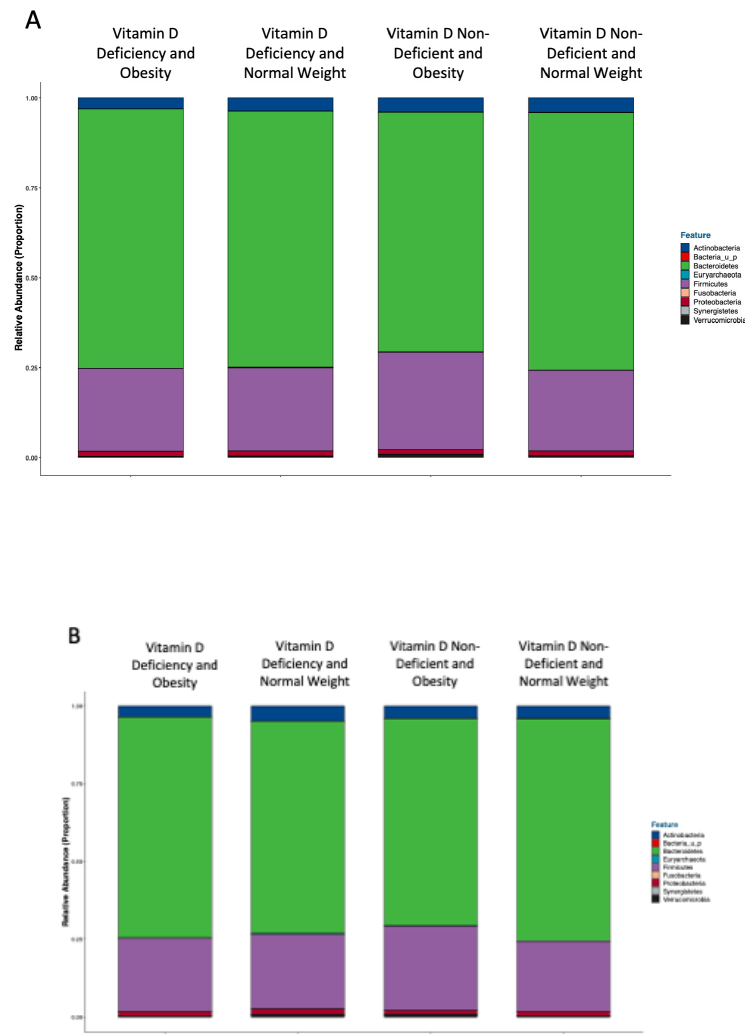
Figure 2. Classification of gut microbiota at the phylum level according to categories of vitamin D deficiency. ( A ) Classification of gut microbiota at the phylum level according to categories of vitamin D deficiency (<50 nmol/L) relative to obesity (<50 nmol/L) and relative to BMI. ( B ). Classification of gut microbiota at the phylum level according to categories of severe vitamin D deficiency (<25 nmol/L) relative to obesity.